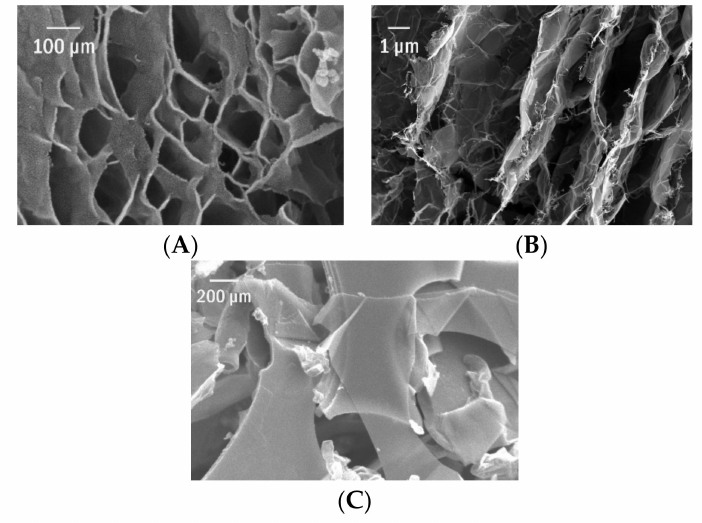
Figure 2. The SEM pictures of the variety of carbon-based nanocomposites fillers: ( A ) exfoliated carbon, ( B ) expanded graphite, ( C ) graphene